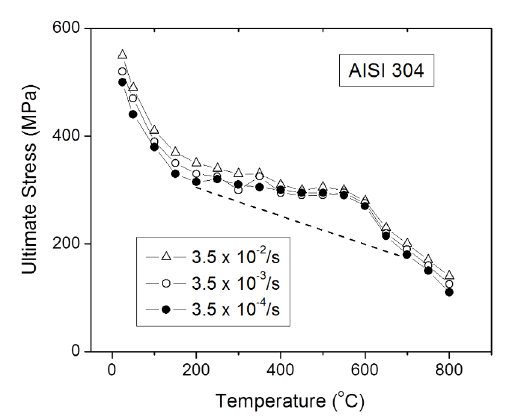
Figure 3. Temperature dependence of the ultimate tensile strength in AISI 304 steel.